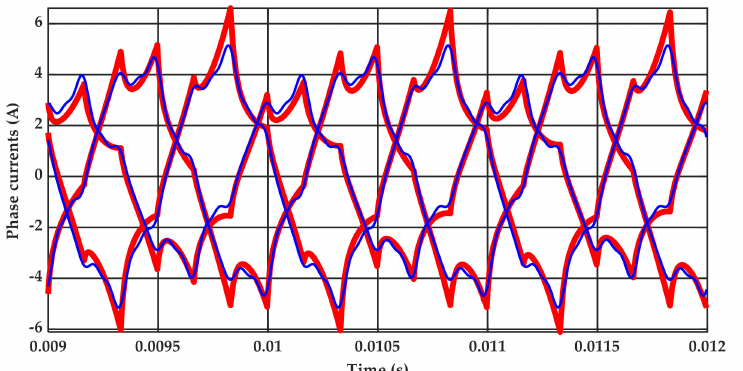
Figure 7. Comparison of the phase currents waveforms calculated with the use of the model formulated in the time domain (red line) with the waveforms calculated with the use of the developed method (blue line), as a superposition of harmonic waveforms, for the rotational speed of 24,000 rpm when supplied with square waveforms and 25% amplitude